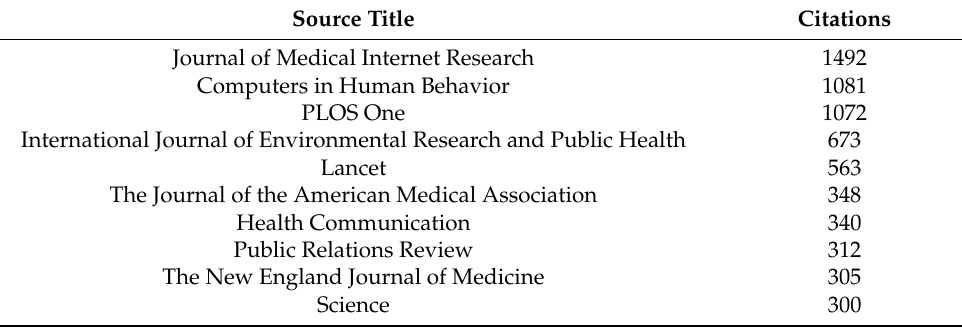
Table 4. Top 10 most local cited sources.